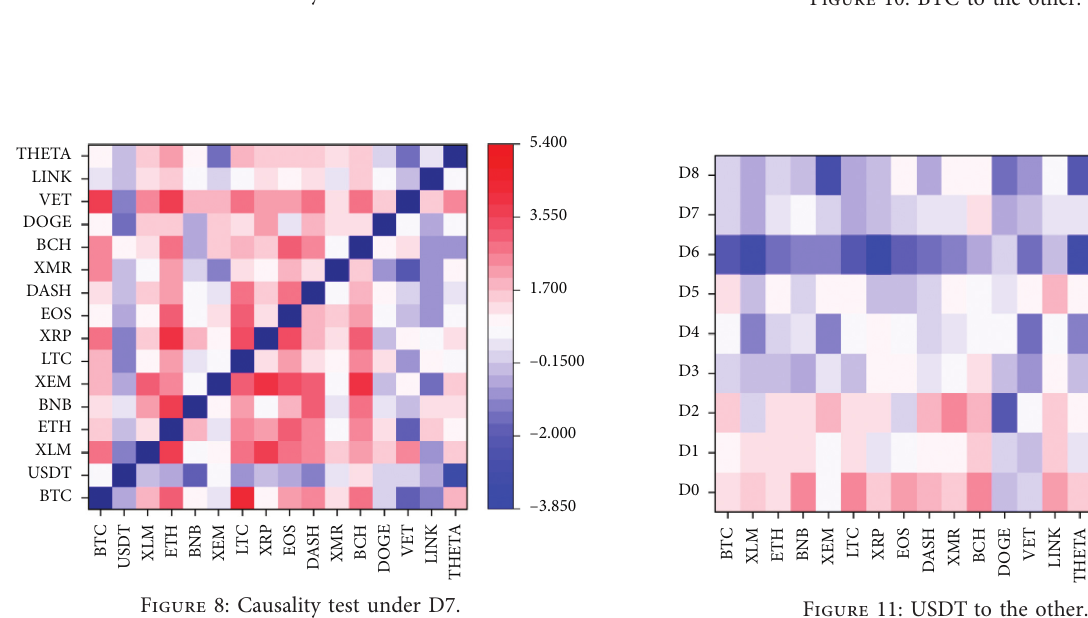
Figure 7: Causality test under D6.